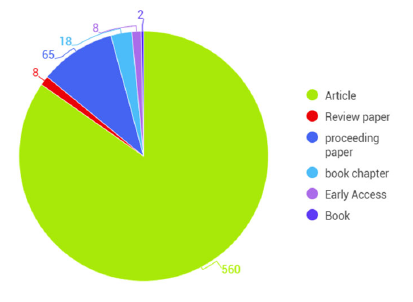
Fig. 2. Details of Search